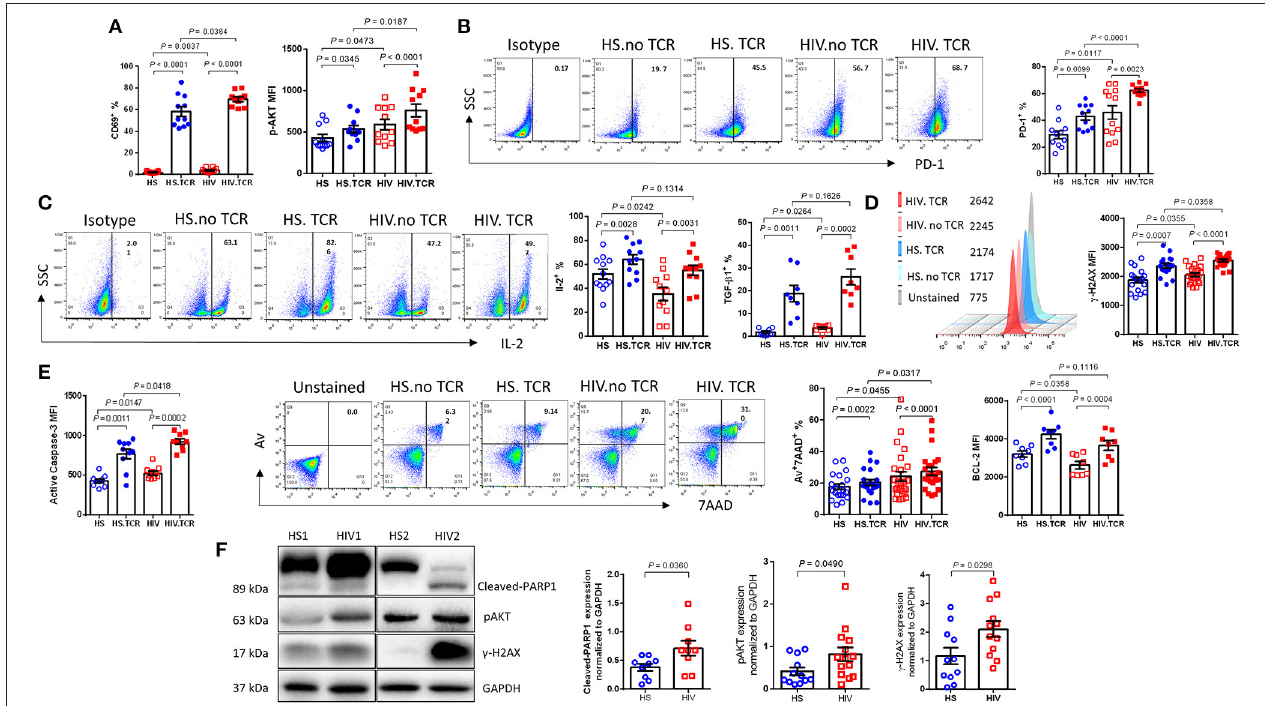
FIGURE 3 | PLHIV on ART exhibit CD4T cell dysregulation and apoptosis due to aberrant DDR. T cell activation, exhaustion, cytokine production, apoptosis, and DNA damage marker expressions in TCR-stimulated or non-stimulated CD4T cells isolated from HS or PLHIV were determined by Flow Cytometry and Western Blot. (A) Frequency of CD69 + ( n = 11) and MFI of pAKT + cells ( n = 11). (B) Representative dot plots and summary data of PD-1 + cells ( n = 12). (C) Representative dot plots and summary data of IL-2 expression ( n = 12), expression of TGF β 1 ( n = 8). (D) Representative histogram and summary MFI of γ H2AX in CD4T cells from HS ( n = 18) and PLHIV ( n = 21). (E) Expression of active caspase-3 ( n = 10), representative dot plots and summary data of Av + 7AAD + CD4T cells from HS ( n = 21) and PLHIV ( n = 25), expression of BCL-2 in CD4T cells from HS and PLHIV ( n = 8). (F) Representative imaging and summary data of immunoblotting for PARP-1, pAKT, and γ H2AX, normalized by